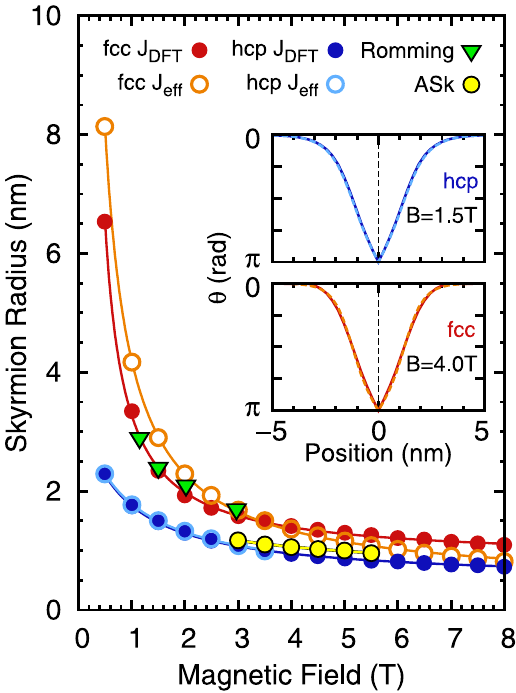
Figure 2. Skyrmion radius vs. magnetic field. Radii of skyrmions in Pd/Fe/Ir(111) obtained for different parameter sets as a function of the applied magnetic field. As a reference, the radii obtained experimentally by Romming et al . 24 are shown as green triangles. Note that we have obtained the skyrmion radii for the experimentally available field strengths by applying our definition of the skyrmion radius to the skyrmion profiles shown in Fig. 3(a) of ref. 24 . Antiskyrmions (ASk) were only metastable for fcc-Pd/Fe/Ir(111) with DFT